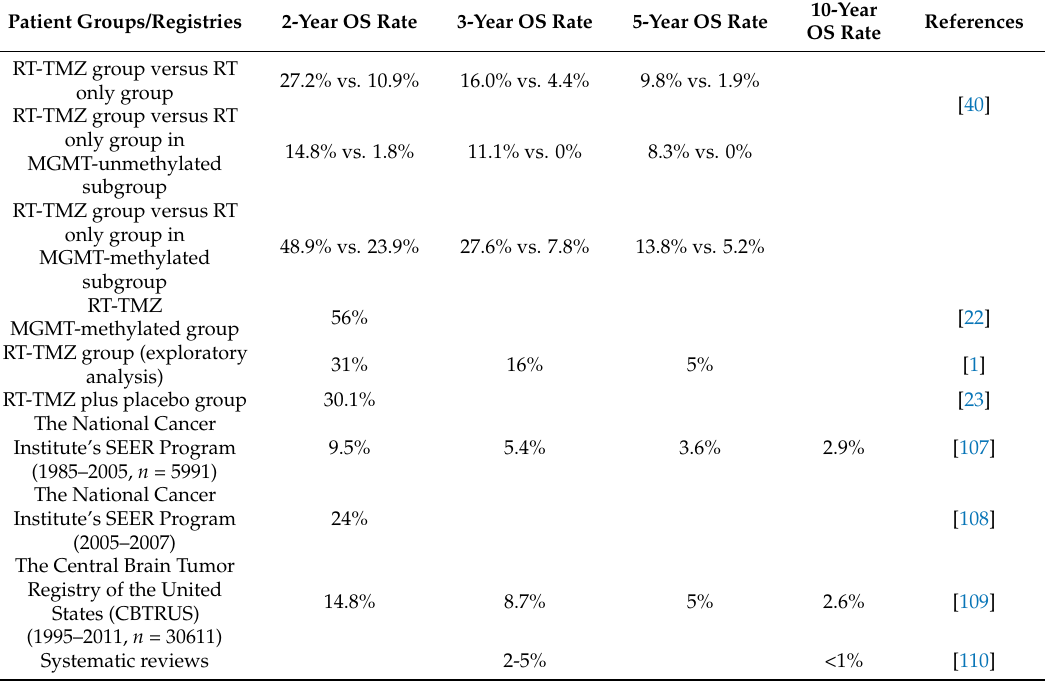
Table 2. The 2-, 3-, 5-, and 10-year overall survival (OS) rates for glioblastoma patients in clinical trials, registries and systematic